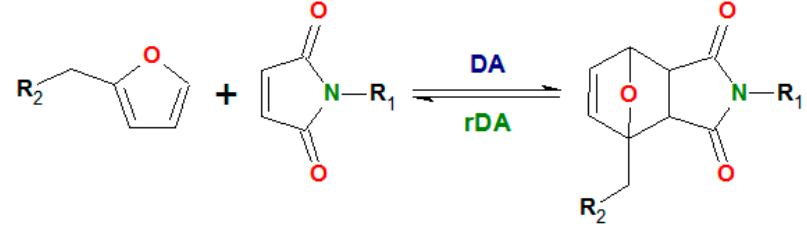
Scheme 1. Diels-Alder reaction of furan and maleimide